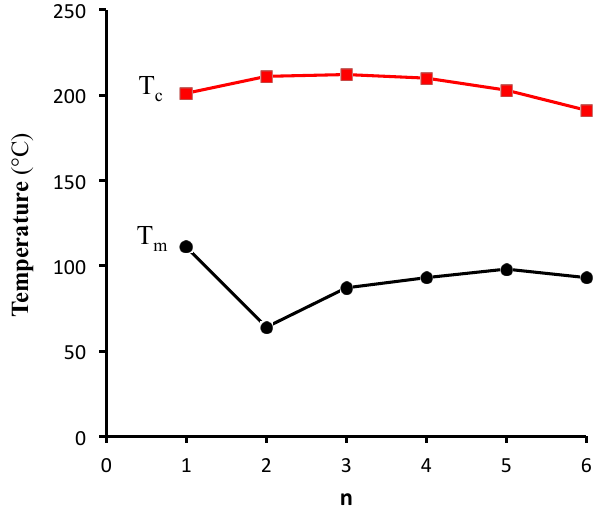
Figure 6. Plot of melting ( T m , black circles) and clearing ( T c , red squares) temperatures of linear alkyl esters 2a – f , as a function of ester chain length, where n = #carbons in alkyl chain of ester ( i.e. , 2a , n = 1; 2b , n = 2, etc.